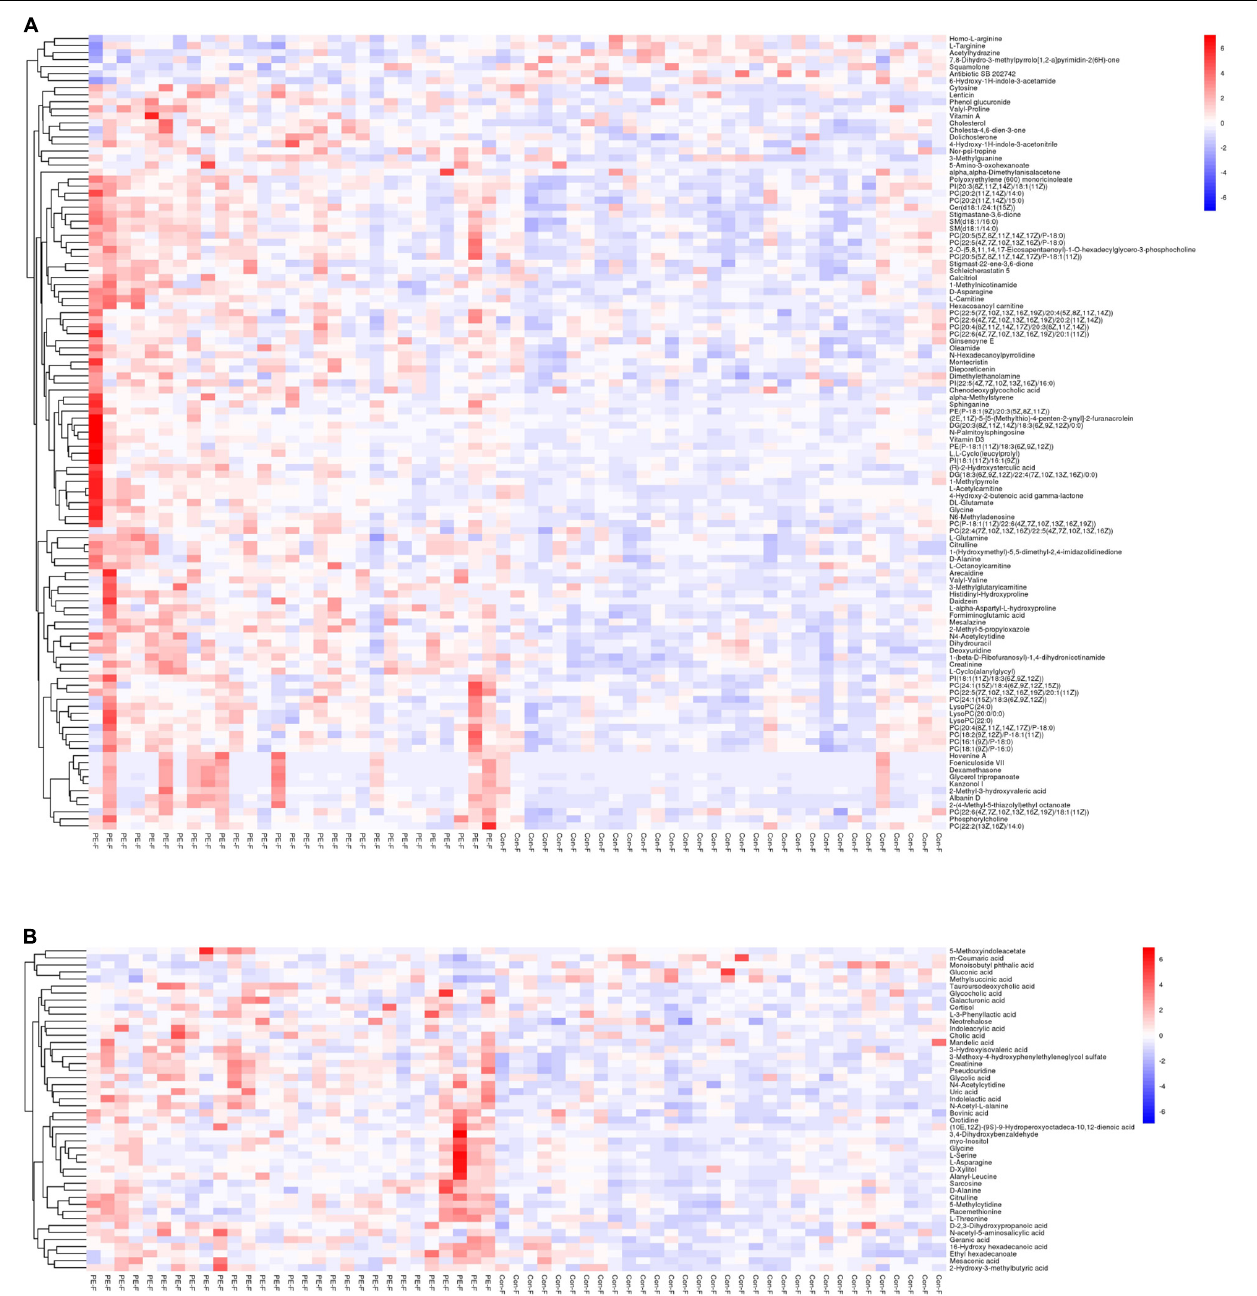
FIGURE 3 | The heatmap showing the hierarchical clustering characteristics of metabolites of PE and non-PE neonates. The color blue indicates decreasing expression, and red indicates increasing expression. The color intensity reflects the corresponding abundance difference. (A) Differential metabolite characteristics of the UHPLC-QE-MS (+) model. (B) Differential metabolite characteristics of the UHPLC-QE-MS (–) model.